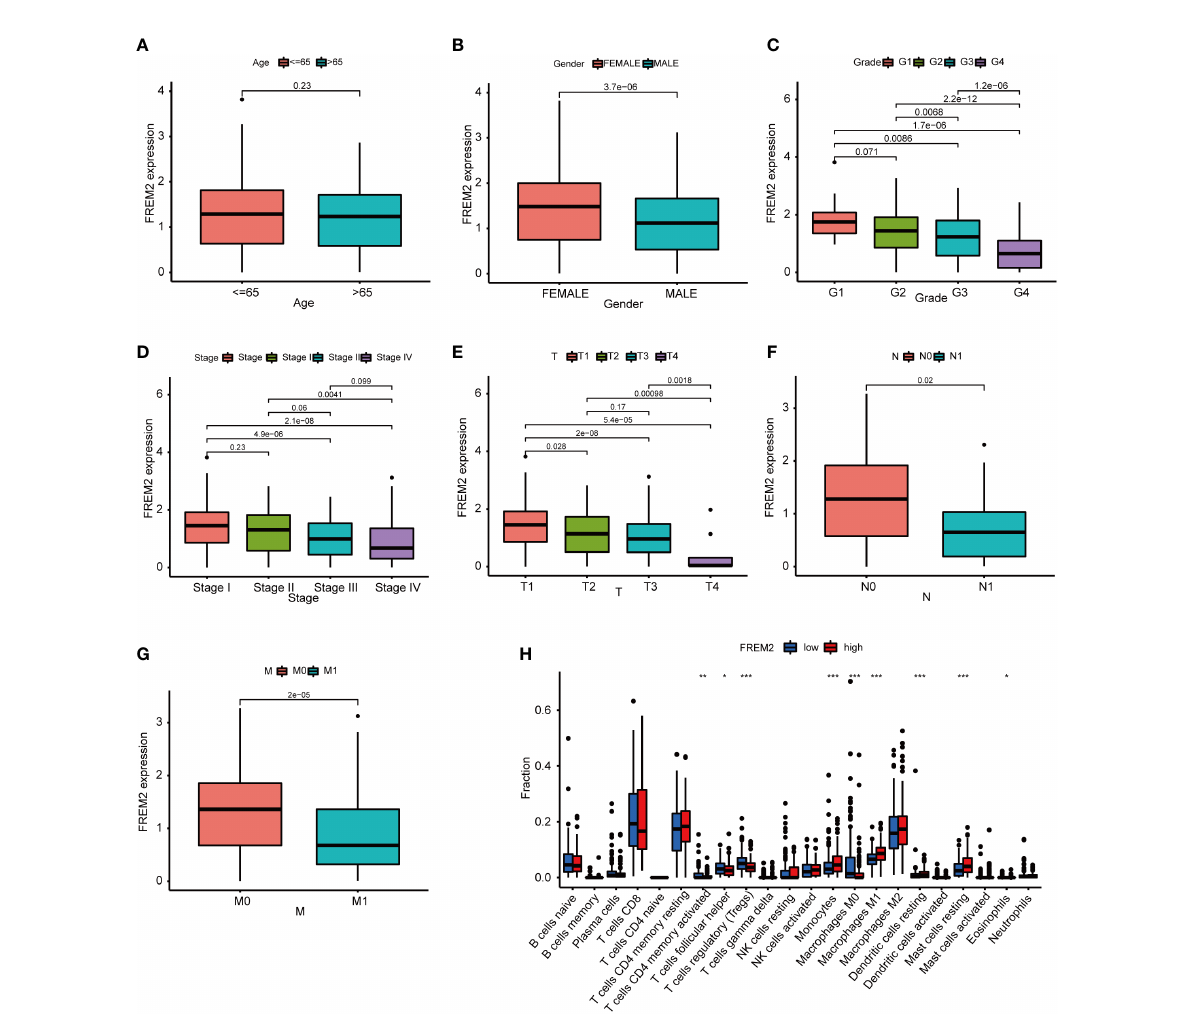
FIGURE 10 The relationship between FREM2 expression level and pathological features, as well as immune cell in patients with high and low FREM2 mRNA expression. (A – G) . The relationship of FREM2 expression level and clinicopathological features. (H) The relative proportion of immune cells using ssGSEA in patients with high and low FREM2 mRNA expression. * p < 0.05, ** p < 0.01, and *** p <